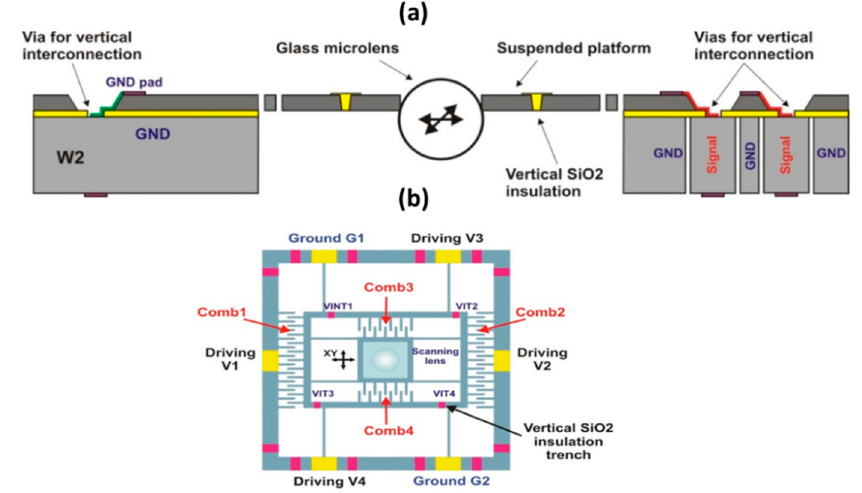
Figure 10. Electrostatic comb-drive x - y microlens scanner: ( a ) construction; and, ( b ) schematic of frame-in-the-frame architecture. Reproduced with permission from [11], published by SPIE, 2009.